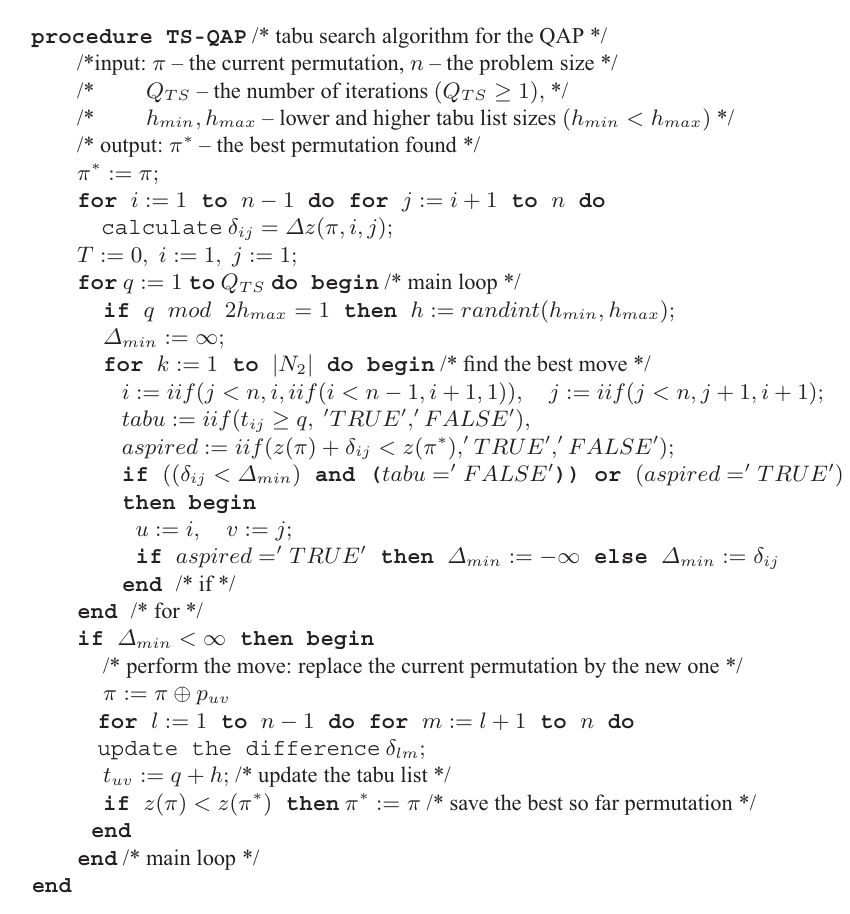
procedure TS-QAP /* tabu search algorithm for the QAP */